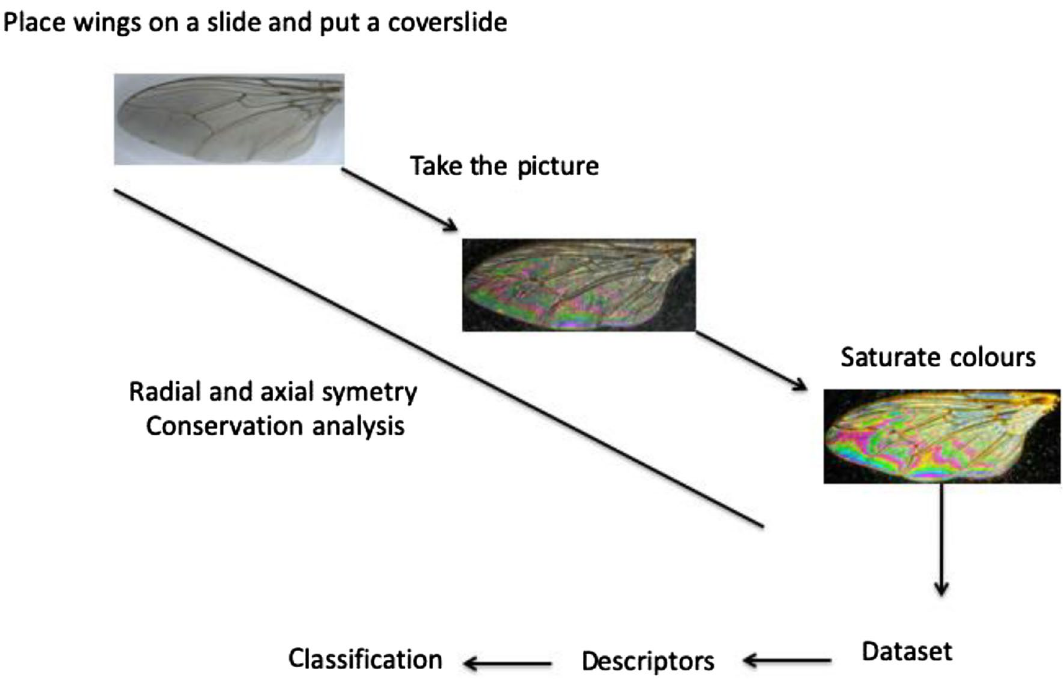
Figure 1. Schematic figure of the flowchart of imaging, labeling process and inclusion in the dataset.